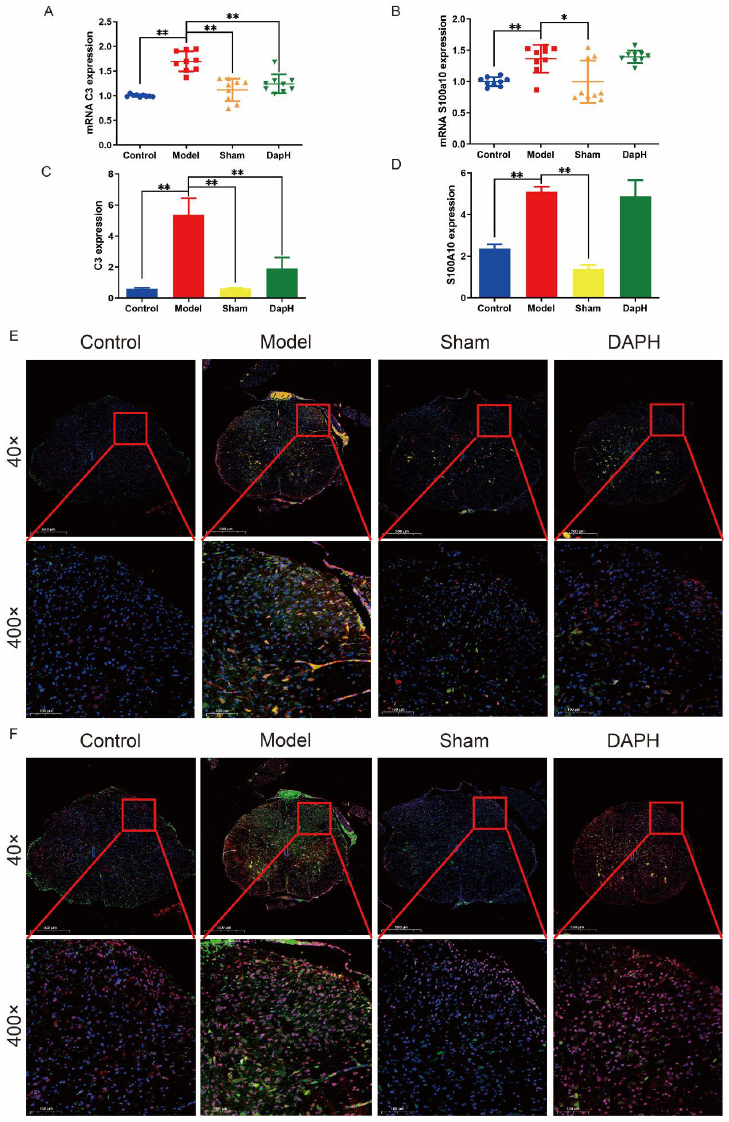
Figure 2. Effect of daphnetin on astrocyte polarization in the spinal cord of NP rats. ( A ) mRNA expression of A1 astrocyte markers in the spinal cord ( n = 3). ( B ) mRNA expression of A2 astrocyte markers in the spinal cord ( n = 3). ( C ) Immunofluorescence intensity of C3 in immunofluorescence sections ( n = 3). ( D ) Immunofluorescence intensity of S100A10 in immunofluorescence sections ( n = 3). ( E ) Immunofluorescence double staining of C3 (red) and GFAP (green) in the spinal cord of NP rats ( n = 3). ( F ) Immunofluorescence double staining of S100A10 (red) and GFAP (green) in the spinal cord of NP rats ( n = 3). * p < 0.05, ** p < 0.01. The blue circles, red squares, green and yellow triangles refer to the individual data of the Control, Model, Sham and DAPH groups,